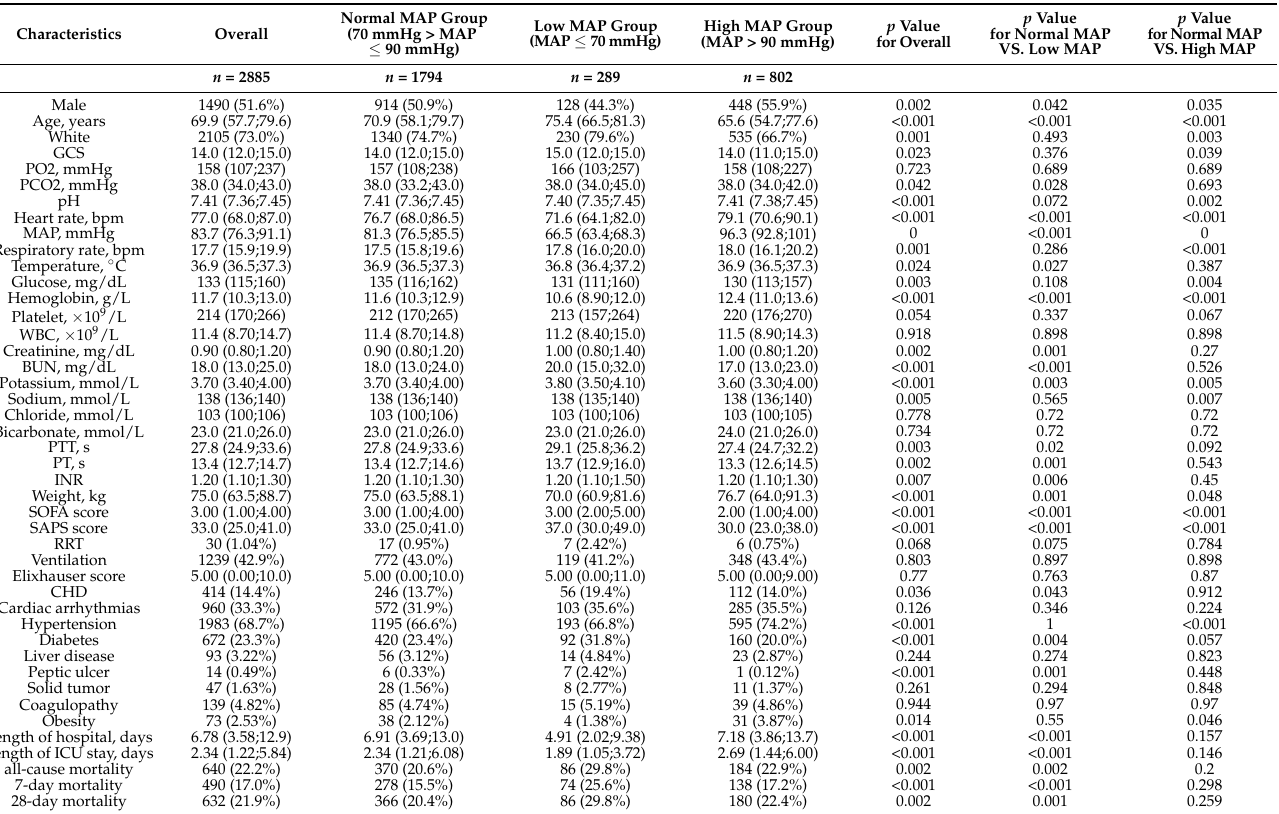
Table 1. Characteristics of acute stroke patients with normal MAP, low MAP, and high MAP on